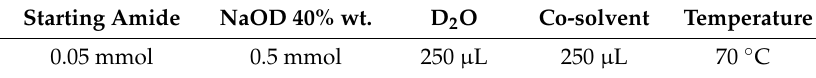
Table 2. Final conditions for alkaline hydrolysis of amide compounds.